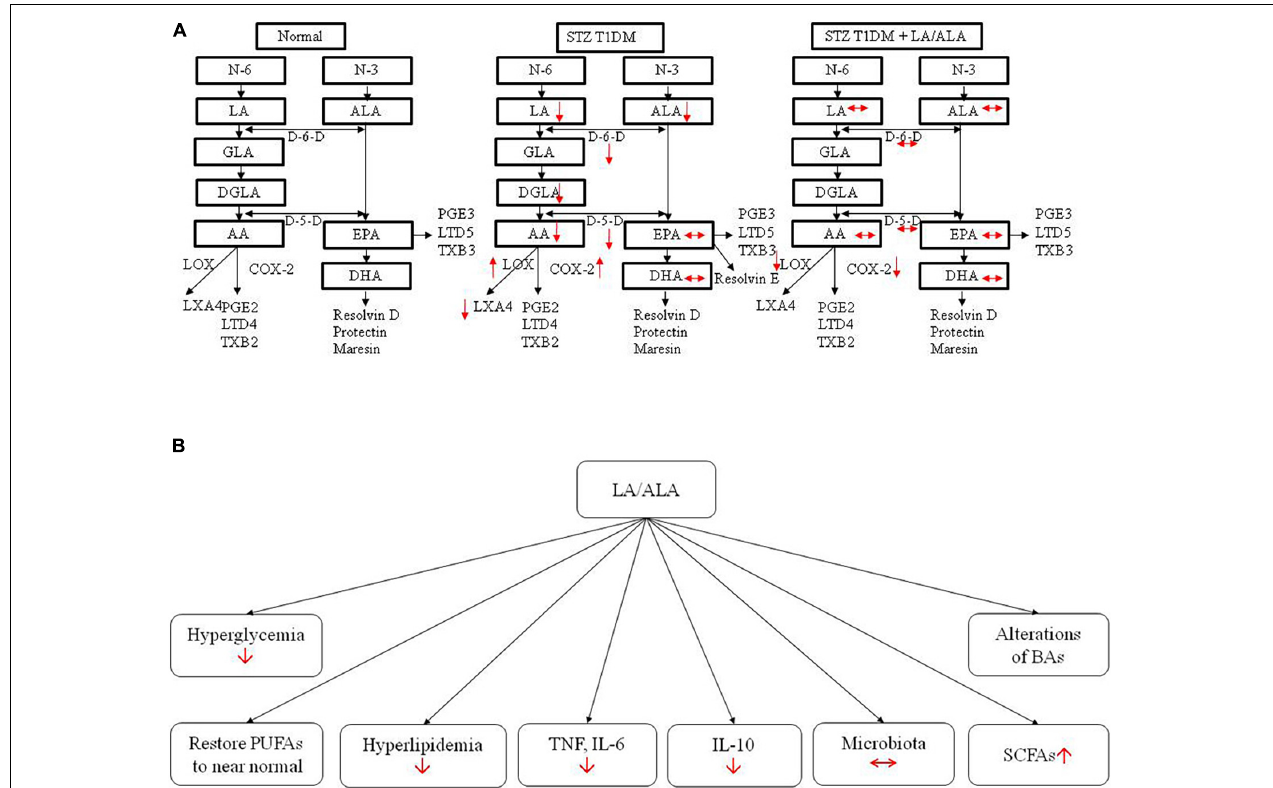
FIGURE 9 | Actions of LA/ALA treatment of STZ-induced T1DM animals (A) and potential mechanisms (B) . LA, linoleic acid; ALA, alpha-linolenic acid; GLA, Gamma linolenic Acid; DGLA, dihomo-gamma-linolenic acid; PUFA, polyunsaturated fatty acid; AA, arachidonic acid; EPA, eicosapentaenoic acid; DHA,